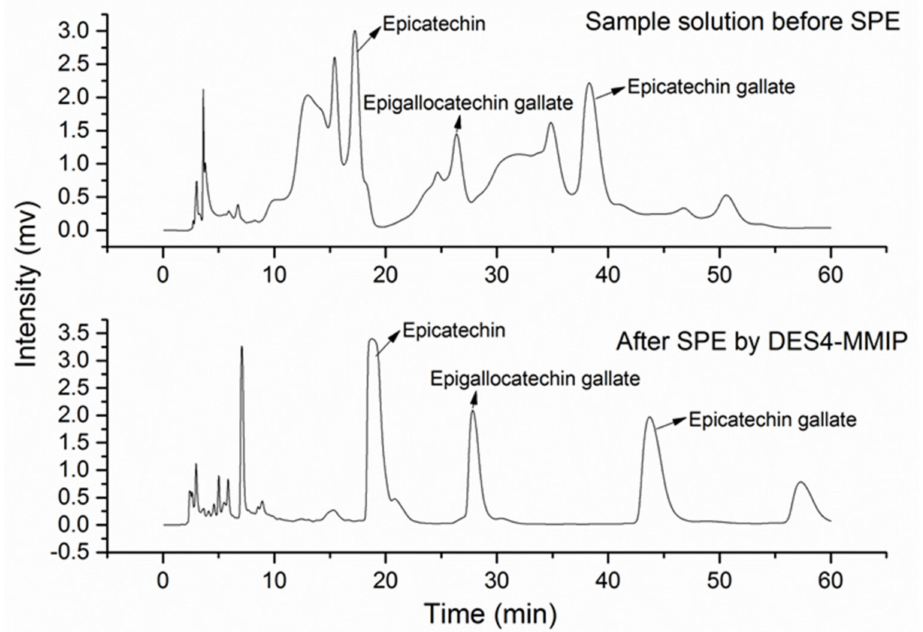
Figure 1. HPLC-UV chromatogram of epicatechin, epigallocatechin gallate, and epicatechin gallate after their extraction from green tea using DES4-MMIP in which DES4 was constituted by ChCl and glycerol at a molar ratio of 1:2. Reprinted from Li, G.; Wang, X.; Row, K. H. Magnetic molecularly imprinted polymers based on silica modified by deep eutectic solvents for the rapid simultaneous magnetic-based solid-phase extraction of Salvia miltiorrhiza bunge , Glycine max (Linn.) Merr and green tea. Electrophoresis, 2018, 39 (8), 1111–1118 with permission from Wiley